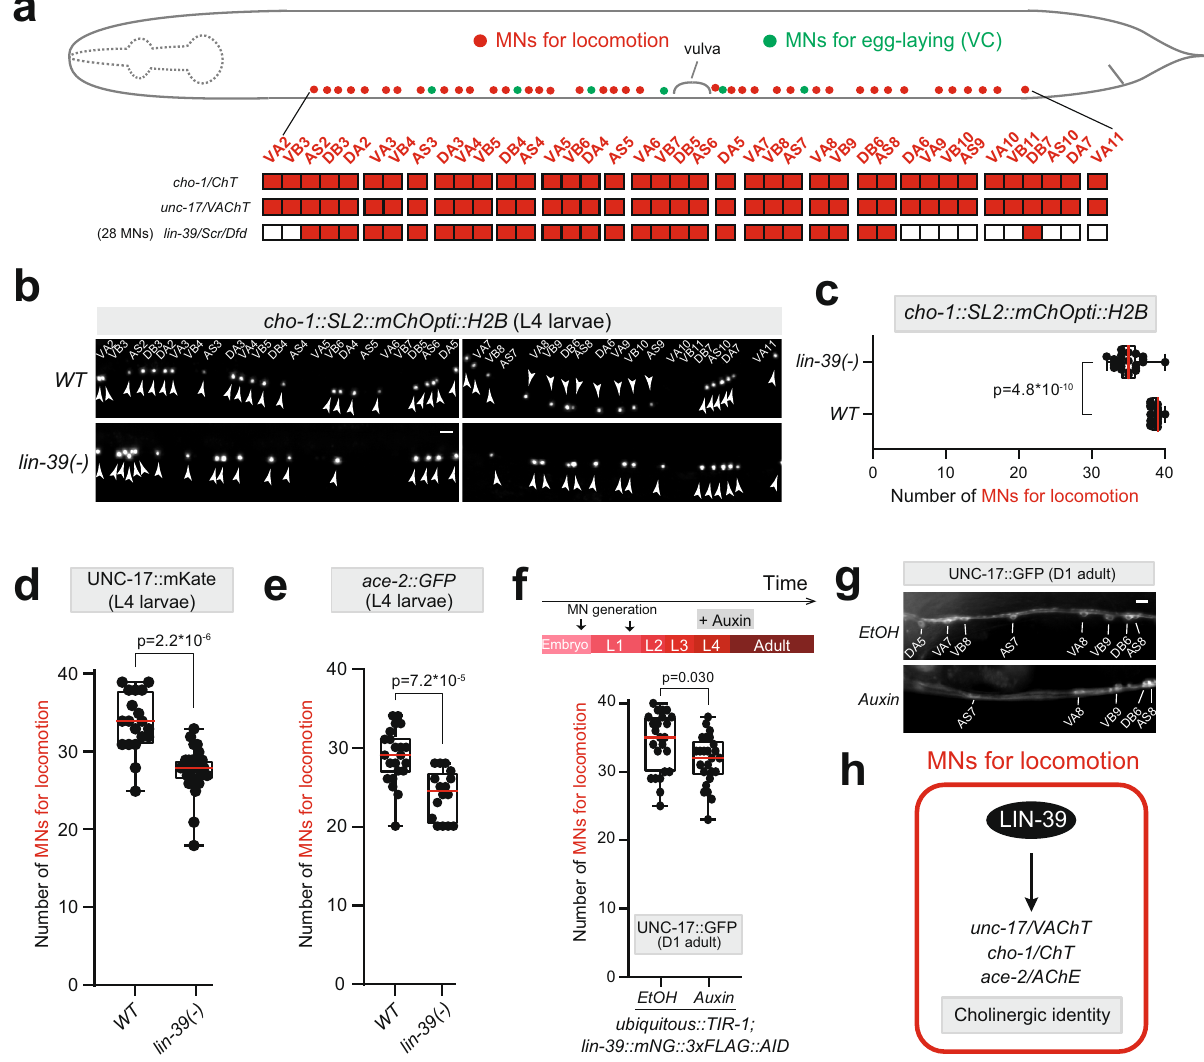
Fig.2|TheHoxgene lin-39(Scr/Dfd/Hox4-5) controlsthecholinergicidentityof motor neurons necessary for locomotion. a Schematic of a C. elegans her- maphroditeshowingthecellbodiesofMNsthatcontrollocomotion(red)andegg- laying (green). Expression pro fi le of cho-1, unc-17 , and lin-39 is summarized in the color- fi lled table. b Representative images of a cho-1 fosmid-based reporter in WT and lin-39(n1760) mutant animals (L4 stage). Motor neurons that control locomo- tion(e.g.,DA,DB,VA,VB)express cho-1 atL4.VCmotorneuronsmaturelater(day1 adult) and do not express cho-1 at L4. The identity of individual motor neurons is annotated. White arrowheads indicate MN nuclei because the cho-1 reporter is localizedtothenucleus(H2B). mChOpti signalisshowninwhiteforbettercontrast. Left image: anterior to the vulva, Right image: posterior to the vulva. c Quanti fi cationofthenumberofmotorneuronsexpressing cho-1 inpanel( b ).The motor neurons that consistentlylose cho-1 expression in lin-39(n1760) mutants are